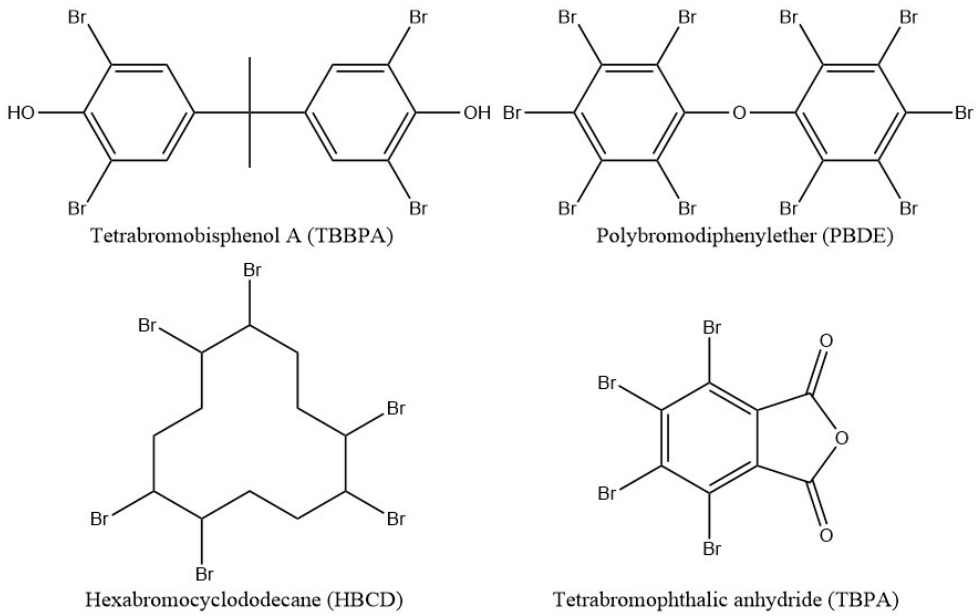
Scheme 2. Examples of the traditional halogenated flame retardants.